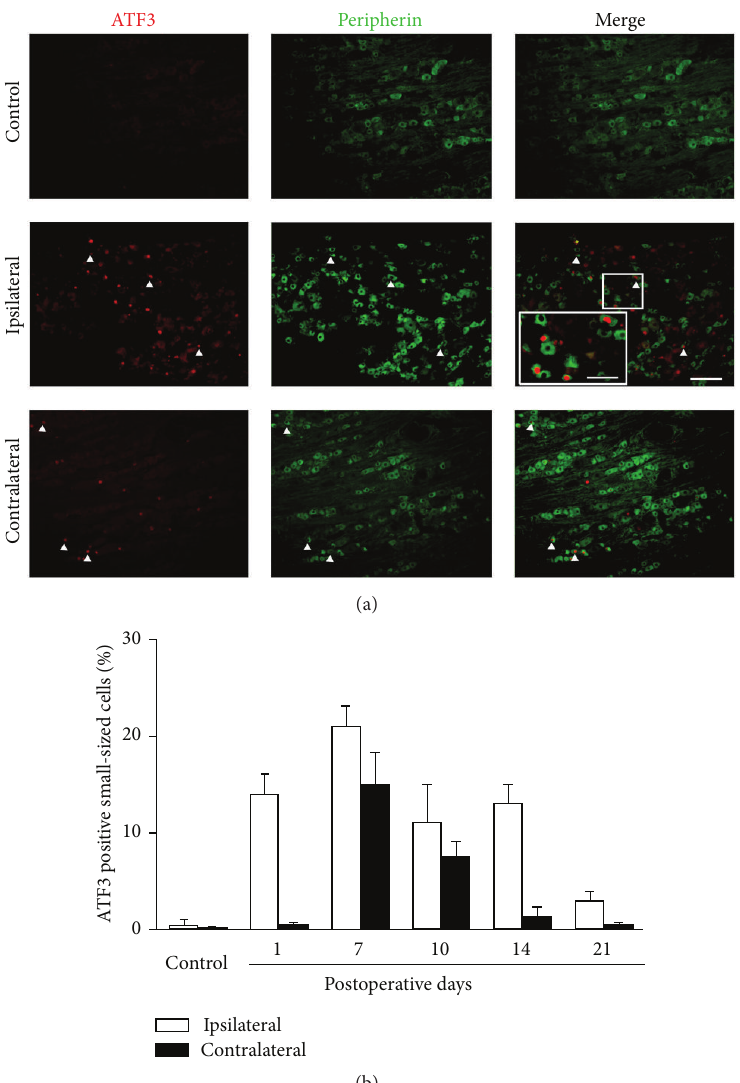
Figure 7: Increased ATF3 expressions in ipsilateral and contralateral small-sized DRG neurons following the mCCD. (a) ATF3 expression in ipsilateral small-sized DRG neurons of control rats. (b) ATF3 expression in ipsilateral small-sized DRG neurons at day 10 after mCCD surgery. C, ATF3 expression in contralateral small-sized DRG neurons at day 10 after mCCD surgery (inset: higher magnification, scale bar = 20 𝜇 m). D, The percentage of ATF3 positive cells in ipsilateral and contralateral small-sized DRG neurons in control and on the 1st, 7th, 10th, 14th, and 21st postoperative days. Scale bar = 50 𝜇 m (a–C). Bonferroni test, 𝑃 < 0.001 , compared to the bilateral DRG neurons of control